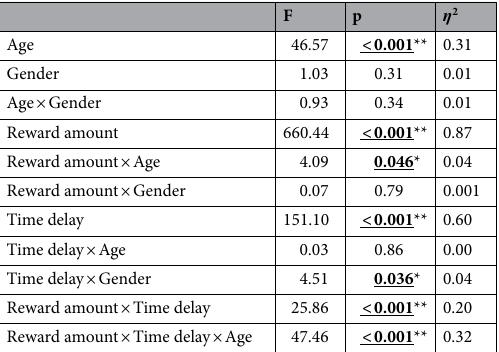
Table 4. Main and interaction effects in the ANOVA analyses for the ratio of immediate choices. *Significance ≤ 0.05, **Significance ≤